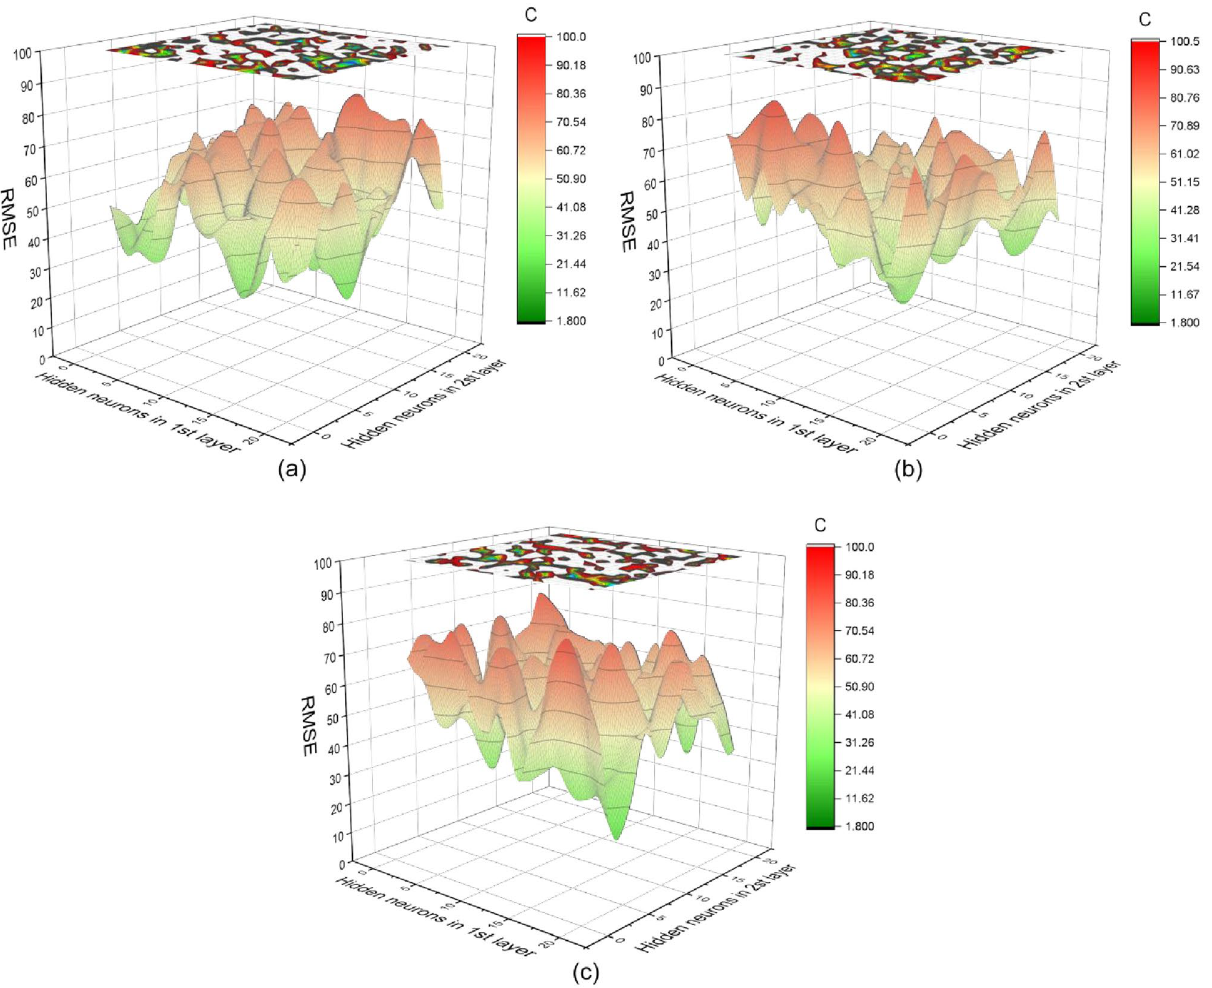
Figure 15. RMSE values for different BPNN models {( a ) Log-sigmoid, ( b ) Tan-sigmoid, ( c ) Purelin}.